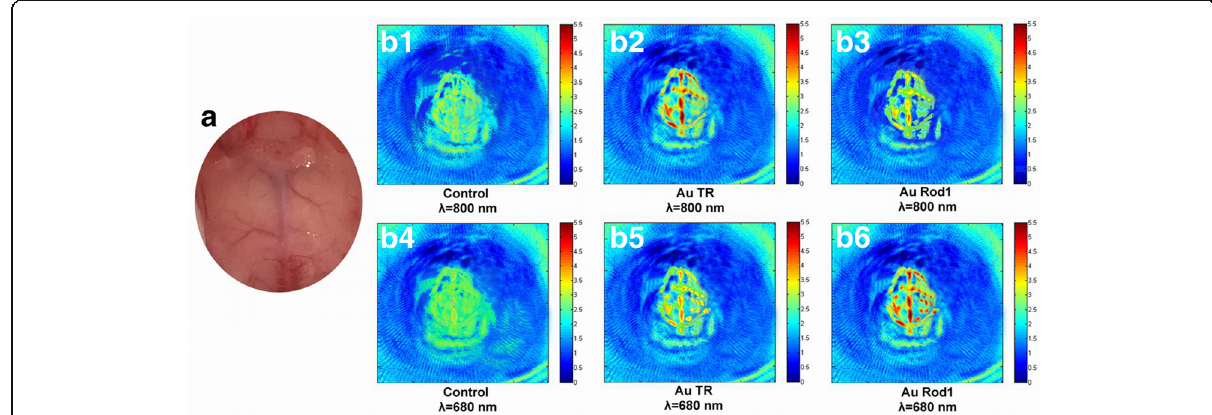
Fig. 5 Photograph and PA images of mouse brain blood vessels: a photograph of mouse cerebrovascular, b PA images scheme of the mouse cerebral blood vessels before and after intravenous injection of AuTR or Au rod1, irradiated by 800- and 680-nm wavelength laser